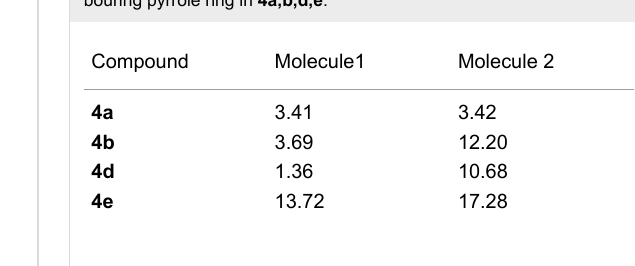
leading to the radical cation and the second to the dication.